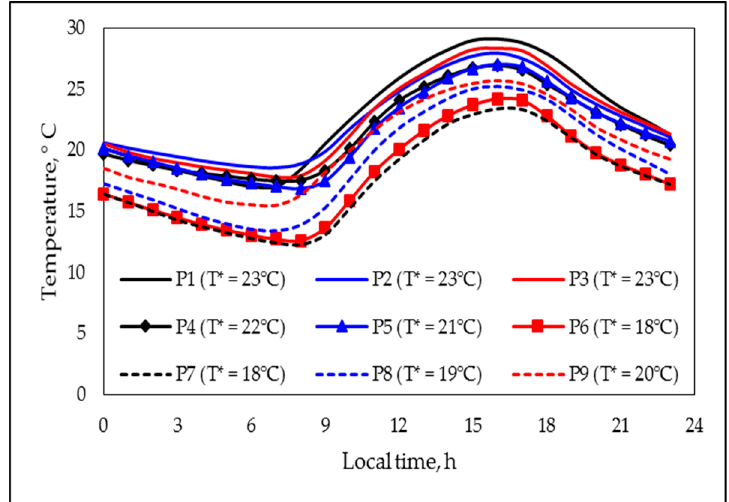
Figure 1. Representative temperature profiles and temperature (T*) values, corresponding to the indicated degradation periods (see codes in image).